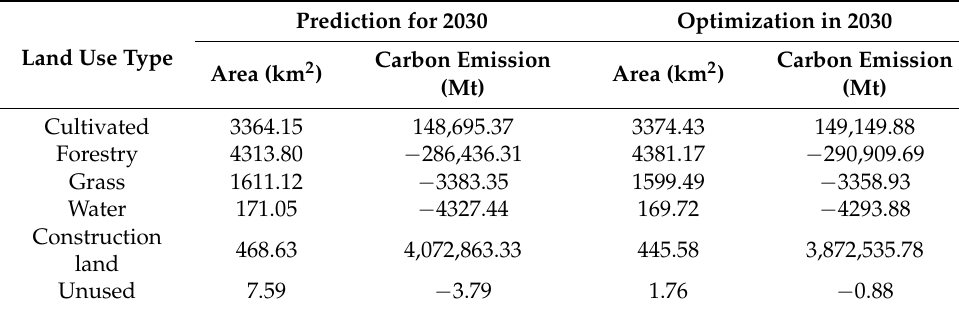
Table 5. Carbon emissions in 2030 for predicted and optimized land use patterns.